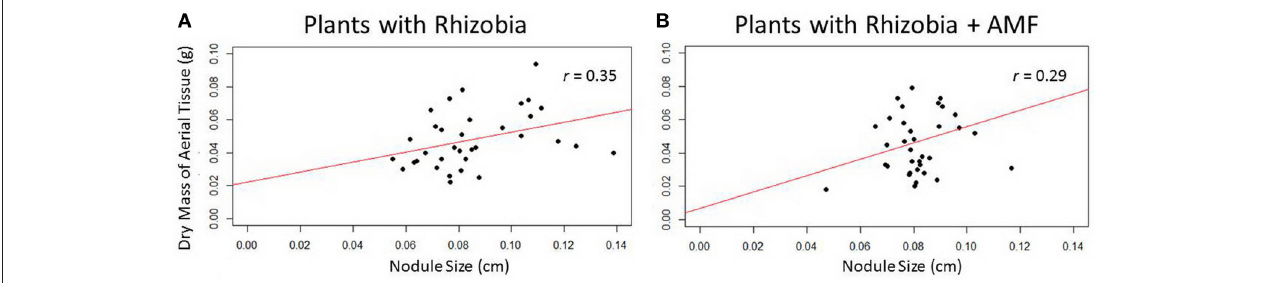
FIGURE 9 | Scatterplots depict the relationship between nodule size and dry mass of aerial tissue. (A) Plants inoculated with only rhizobia ( n = 34 ) showed a significant ( p < 0.05 , p = 0.35 ) positive correlation between nodule size and biomass. (B) Rhizobia + AMF ( n = 35 ) inoculated plants do not have a significant correlation between nodule size and